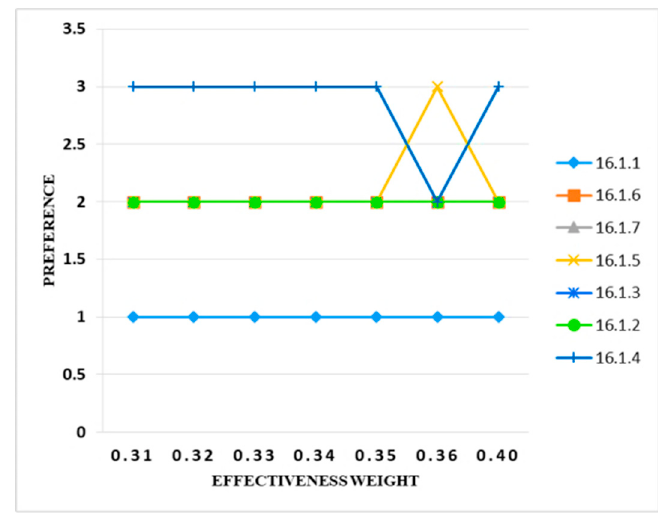
ff ectiveness weight.